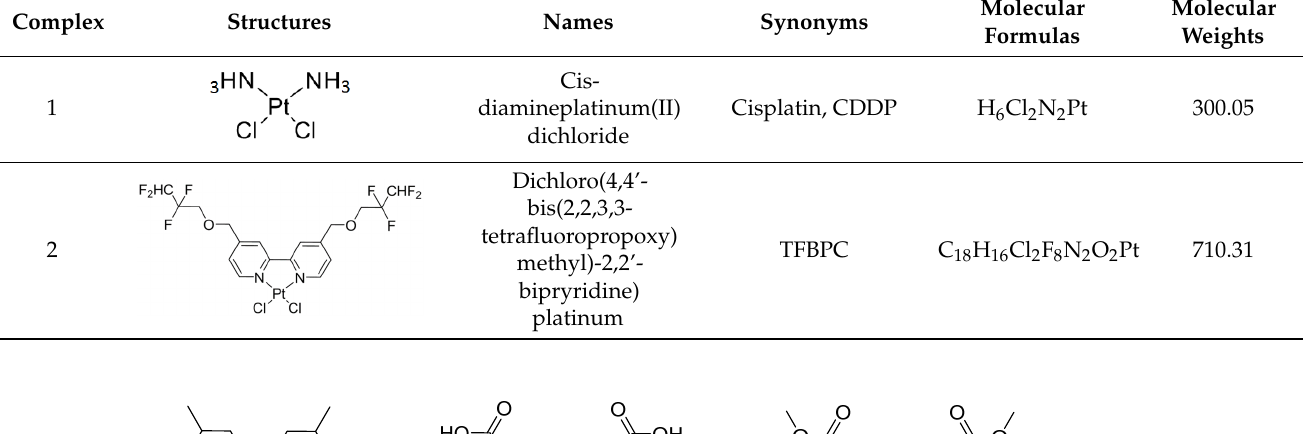
Table 1. Chemical structures and properties of platinum-based agents.